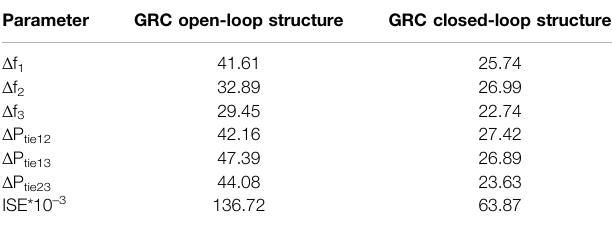
TABLE 4 | Response settling time (in s) with the WCA-tuned 3DOF-PID controller for the three-area RTPS model. Parameter